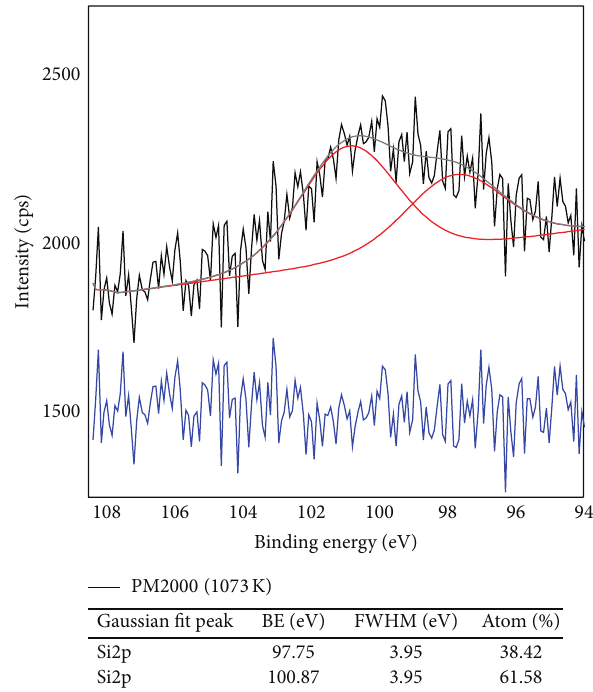
Figure 13: Decomposed Si2p peaks of oxidized PM2000 at 1073